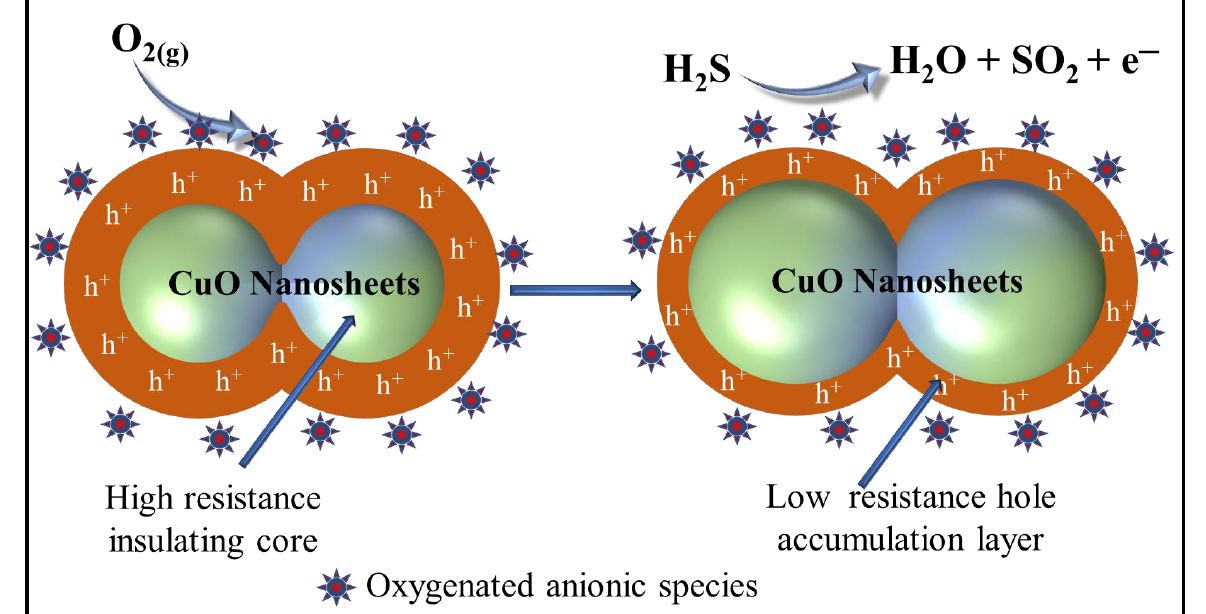
Figure 8. Schematics of the H 2 S gas sensing mechanism by leaf-shaped CuO nanosheets.